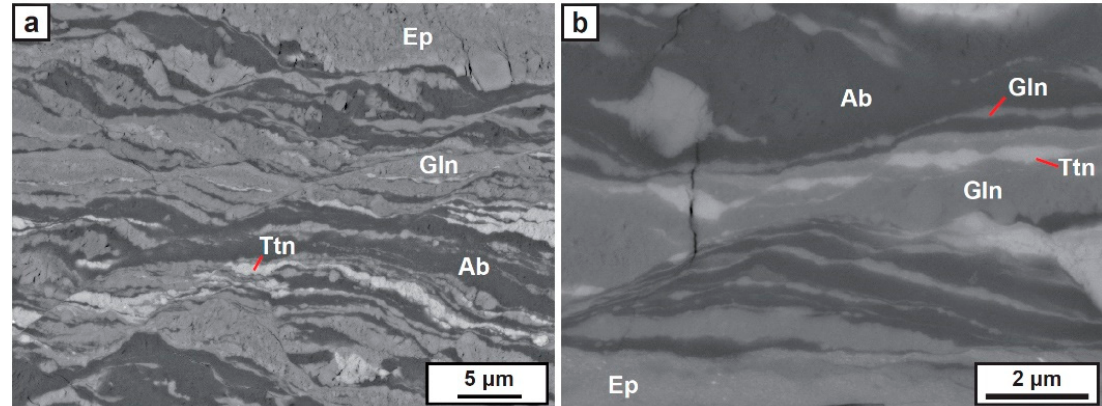
Figure 4. BSE images of sample deformed with high shear strain (JH94a, γ = 4.5). ( a ) Ductile shear band showing C-C’ structure with cataclastic flow texture; ( b ) brittle microfault indicated by the titanite offset and ductile elongated shear band of small glaucophane. All images show the left-lateral (sinistral) shear sense. Gln: glaucophane, Ep: epidote, Ttn: titanite, and Ab: albite.